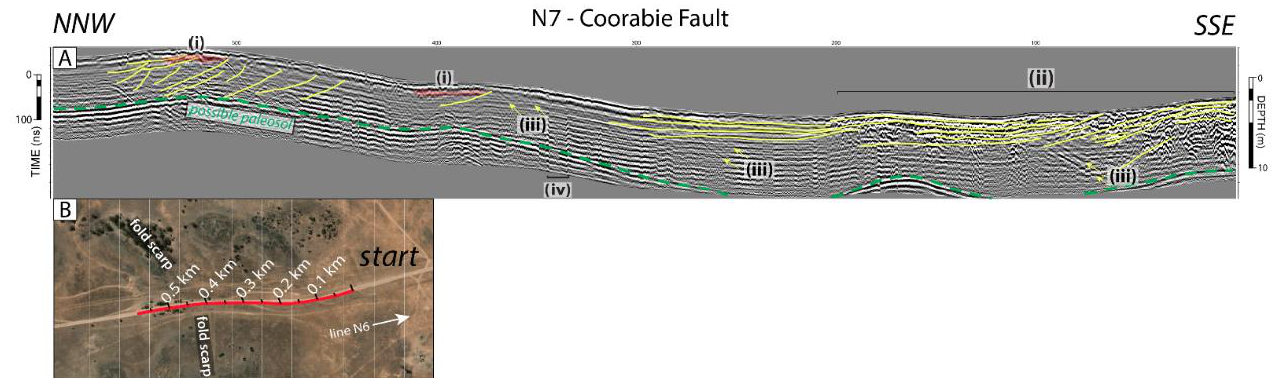
Figure 10. ( A ) Full GPR transect N7. Interpreted reflectors are shown in yellow; ( B ) Orthophoto showing the transect in relation to the surrounding landscape. The fold scarp is imaged by a grey-green ground color as is the ridge towards the start of the transect, visible in the topography along the GPR transect and as grey-green patch in ( B ) below the white arrow; (i): zones of stronger reflector packages, (ii): zone underneath slightly elevated terrain with strong, discontinuous reflectors, with increased penetration depth, interrupted by numerous diffractions; (iii): ‘sideswipe’ from adjacent fencing; (iv): possible trench producing ‘ringing’ at the edges.